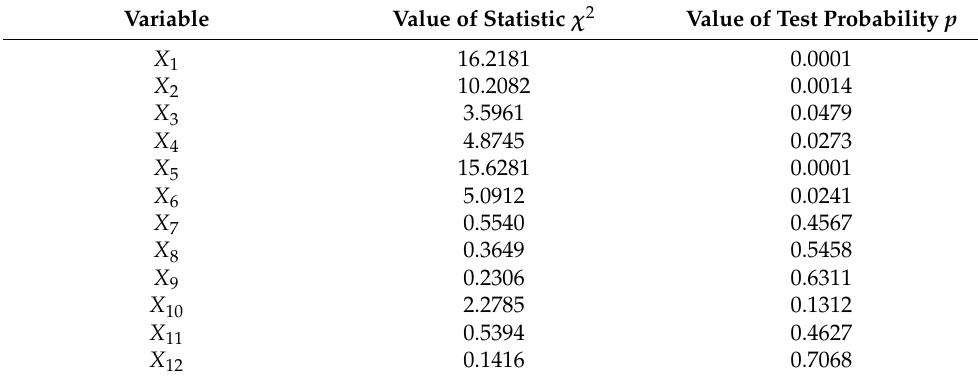
Table 5. Value of statistics χ 2 and test probability p